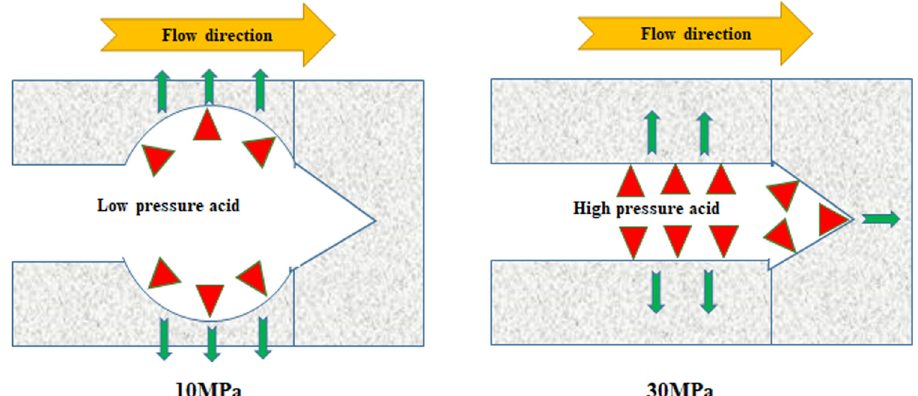
Figure 7: Acidi fi cation position and e ff ect of acid in carbonate rock reservoirs under di ff erent pressures: ( a ) 10 MPa of reservoir pressure; ( b ) 30 MPa of reservoir